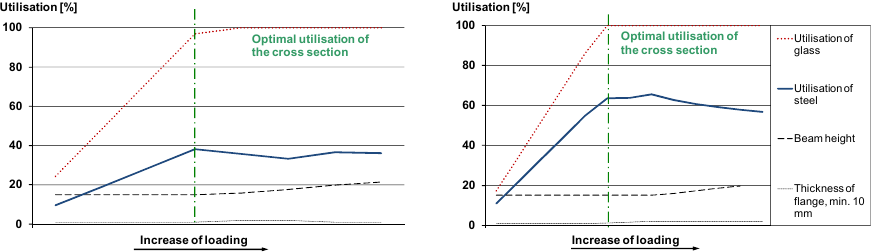
Figure 8a and b: Utilisation of steel and glass for constant cross sections and different shear stiffnesses of the adhesive (left G=5 MPa, right G=20